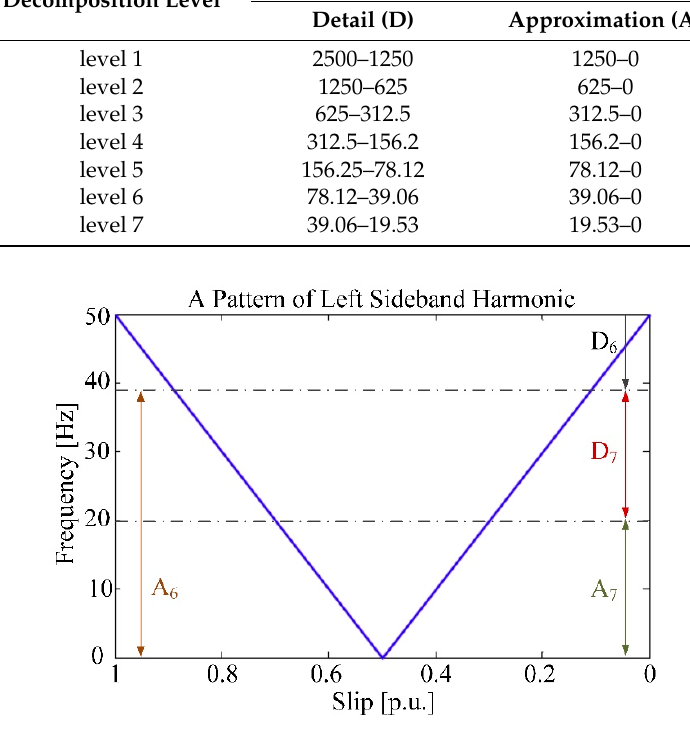
Figure 5. Theoretical behavior of f LSH as a function of slip.